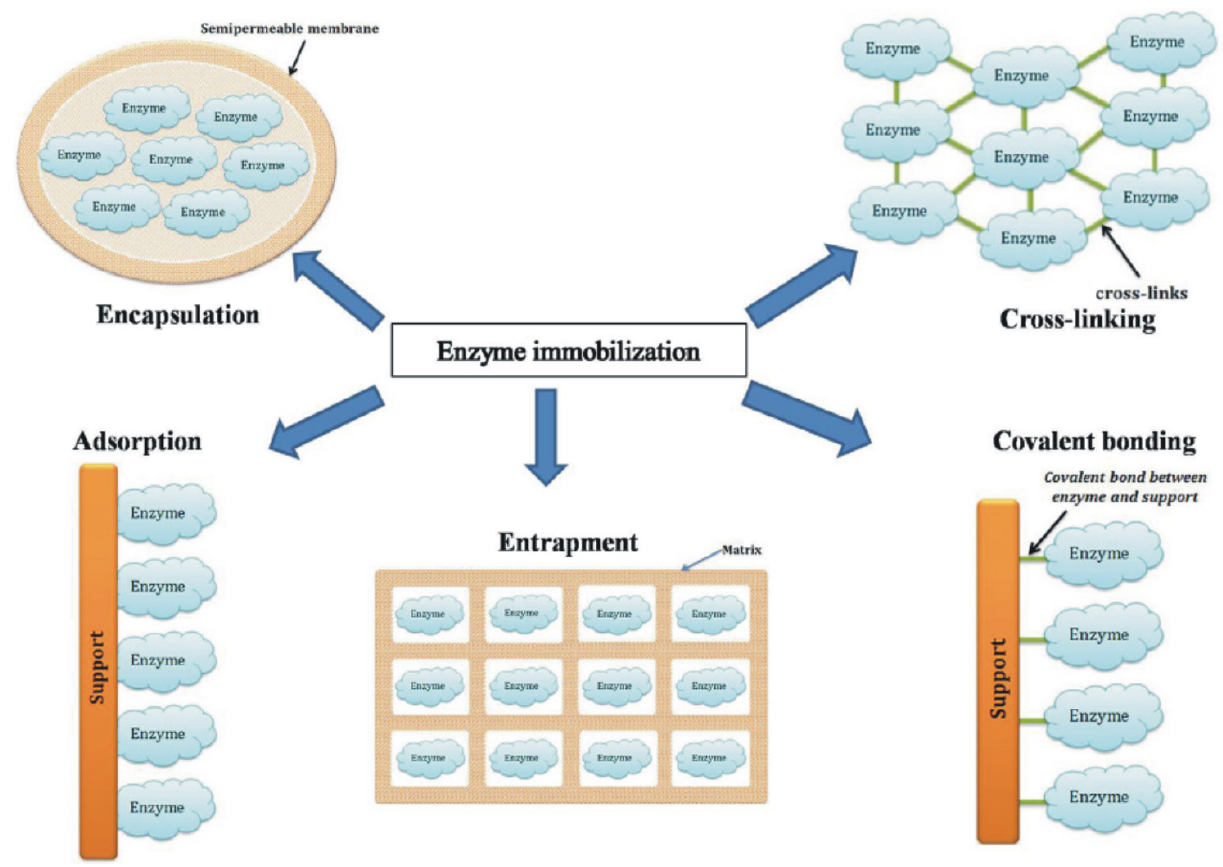
Figure 4. The main techniques of enzyme immobilization. Reprinted from [100] with permission of publisher.